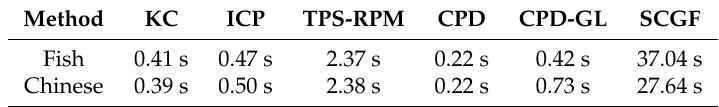
Table 2. Runtime of pairwise point set registration algorithms on different